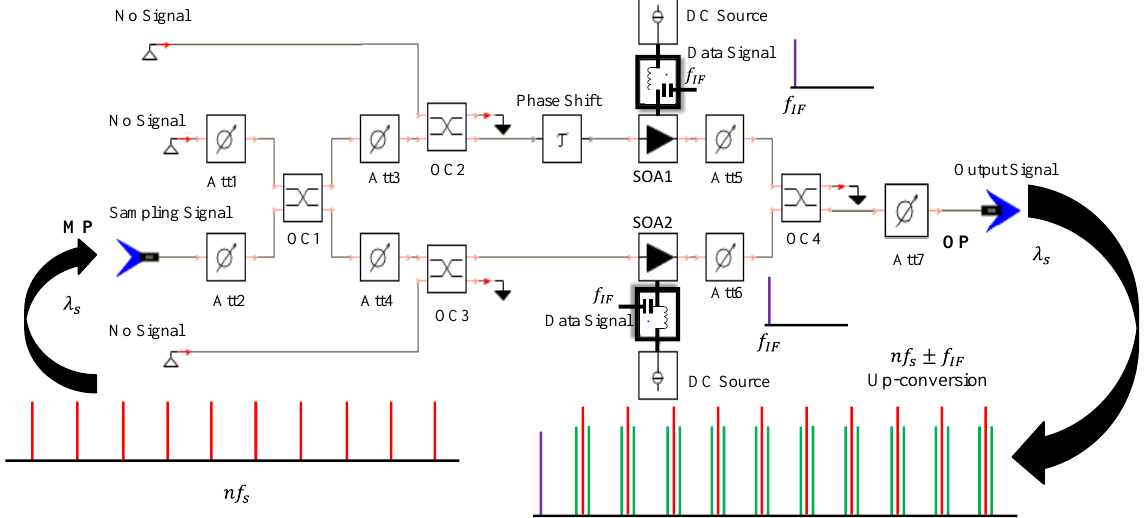
Figure 1. Electro-optical shifting based on a sampling SOA–MZI using the modulation of differential schema. MP: Middle Port, OP: Output Port, OC: Optical Coupler, and Att: Attenuator. The proposed differential modulation relies on two electrical subcarriers in the MZI.